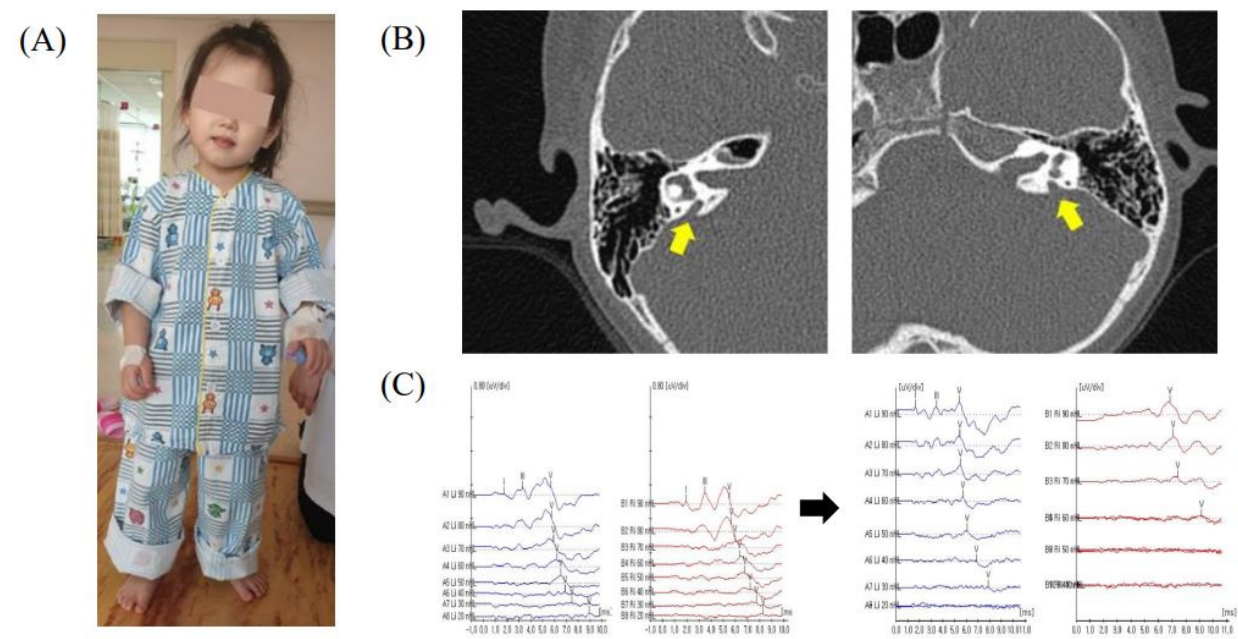
Figure 2. ( A ) General appearance of the third daughter at the time of visit. ( B ) The temporal bone computed tomography of the third daughter showing bilateral enlarged vestibular aqueduct. ( C ) The ABR data during the hospitalization and after 9 months.